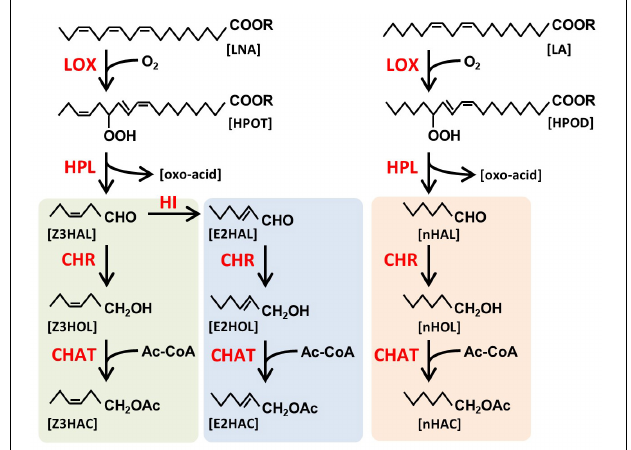
FIGURE 1 | Biosynthetic pathway of green leaf volatiles (GLVs). GLVs are fatty acid-derived volatiles. Linolenic acid (LNA) and linoleic acid (LA) are oxidized by lipoxygenases (LOX) to form 13-hydroperoxy octadecatrienoic acid (HPOT) and 13-hydroperoxy octadecadienoic acid (HPOD), respectively, and subsequently cleaved by hydroperoxide lyase (HPL) to form green leaf aldehydes, ( Z )-3-hexenal (Z3HAL), and n -hexanal (nHAL), respectively. Z3HAL could be converted into ( E )-2-hexenal (E2HAL) by Z3:E2-hexenal isomerase (HI). Three forms of green leaf aldehydes [Z3HAL (green), E2HAL (blue), and nHAL (orange)] are reduced by cinnamaldehyde and hexenal reductase (CHR) to form green leaf alcohols [( Z )-3-hexenol (Z3HOL), ( E )-2-hexenol (E2HOL), and n -hexanol (nHOL), respectively]. The green leaf alcohols are subsequently acylated by acetyl CoA:( Z )-3-hexen-1-ol acetyltransferase (CHAT) to form ( Z )-3-hexenyl acetate (Z3HAC), ( E )-2-hexenyl acetate (E2HAC), and n -hexyl acetate (nHAC) with acetyl CoA as an acyl